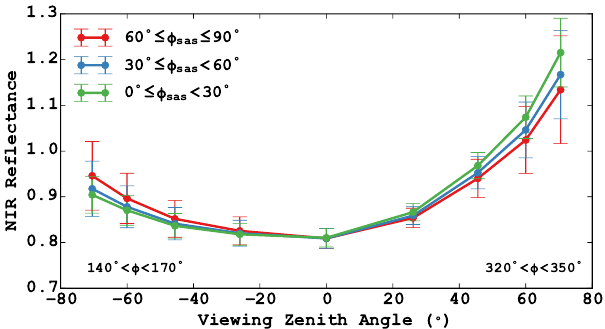
Figure 2. Mean MISR near-infrared reflectance over clear-sky Antarctica for θ 0 = 65–70 ◦ . The reflectances are separated by the φ sas angle (see Fig. 1): 0 ◦ ≤ φ sas < 30 ◦ (green), 30 ◦ ≤ φ sas < 60 ◦ (blue), and 60 ◦ ≤ φ sas ≤ 90 ◦ (red). The error bars represent one standard